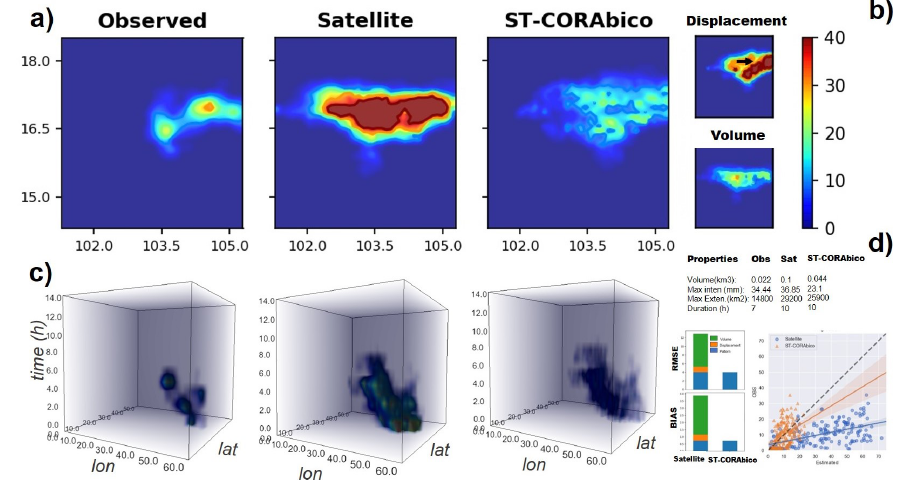
Figure 6. Performance of ST-CORAbico for a short-lived storm event (2014-08-27). ( a ) total events for observed, satellite and ST-CORAbico; ( b ) volume, displacement correction maps; ( c ) four-dimensional (4D) spatiotemporal evolution (lat, lon, time, intensity); and, ( d ) bias, RMSE statistics, and scatter and correlation between observed and estimated rainfall